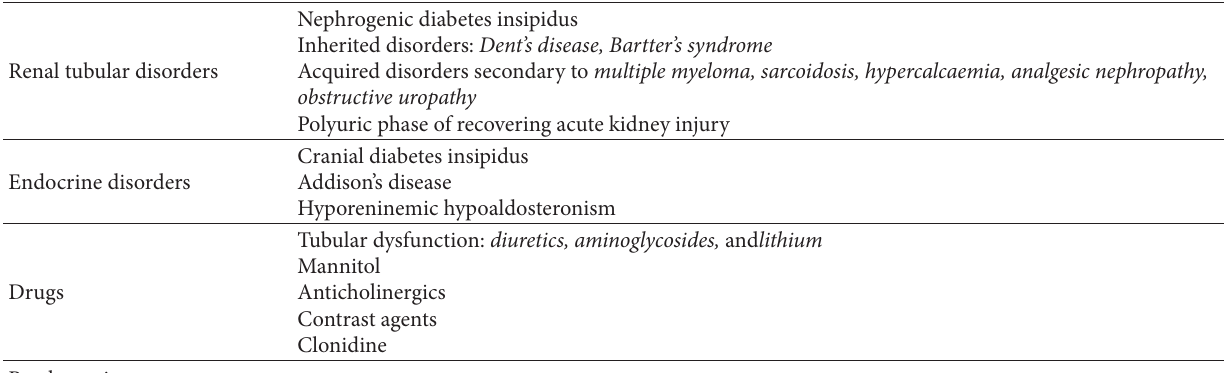
Table 2: Causes of